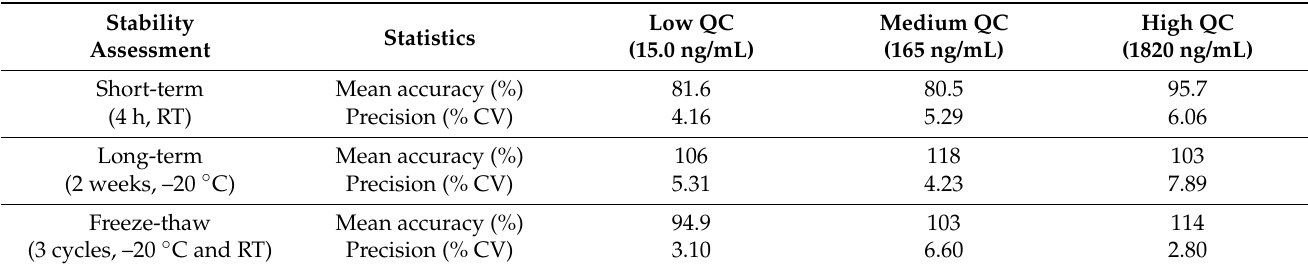
Table 2. Stability tests for α -amanitin in rat plasma.